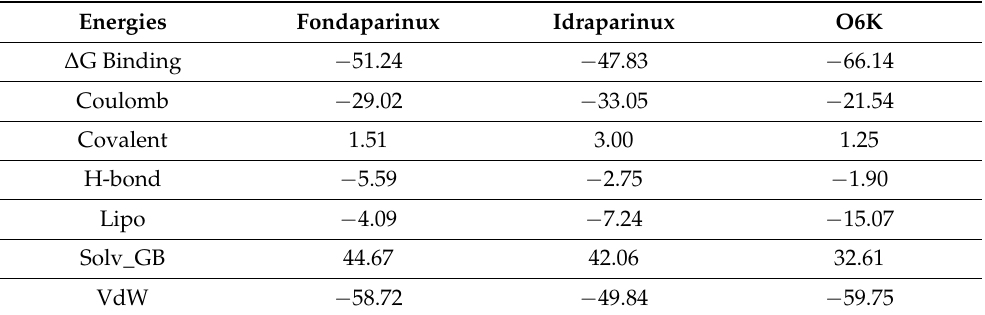
Table 2. MM-GBSA energies for (fondaparinux, idraparinux, and O6K-6Y2G) complexes of 6Y2G protein (kcal/mol). Energies Fondaparinux Idraparinux